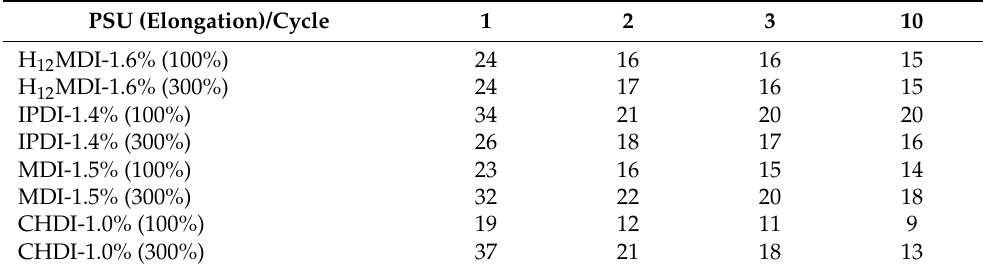
measurements and are rounded to